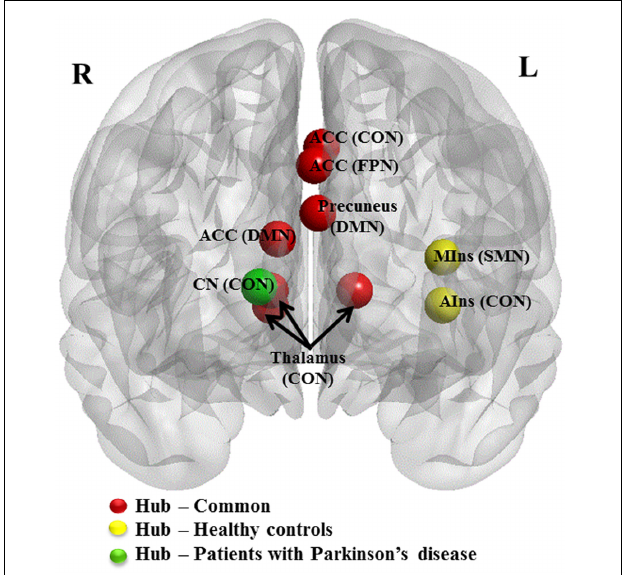
FIGURE 3 | Hub regions in patients with PD and HCs. Caudal view of brain image presenting 10 hub regions. ACC, anterior cingulate cortex; AIns, anterior insula; CN, caudate nuculeus; CON, cingulo-opercular network; DMN, default mode network; FPN, fronto-parietal network; MIns, mid-insula. Seven hubs in red represent common hubs to both HCs and patients with PD. Two in yellow represent hubs identified only in HCs and one in green, only in patients. Brain image and hubs are visualized using the BrainNet Viewer (NKLCNL, Beijing Normal